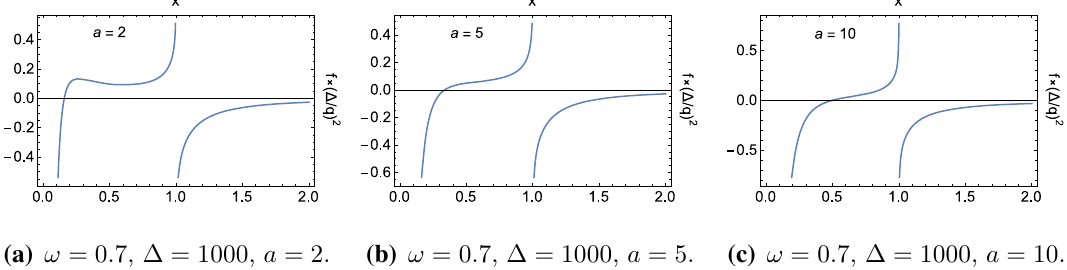
( a ) ω = 0 . 7, Δ = 1000, a = 2. Fig. 3 Dimensionless self-force f × ((cid:14)/ q ) 2 in terms of the dimensionless coordinate x , for increasing values of the throat radius a . The throat is at x = 0 and the exterior shell is at x = 1 global dimensionless coordinate x ∈ ( −∞; +∞ ) ,